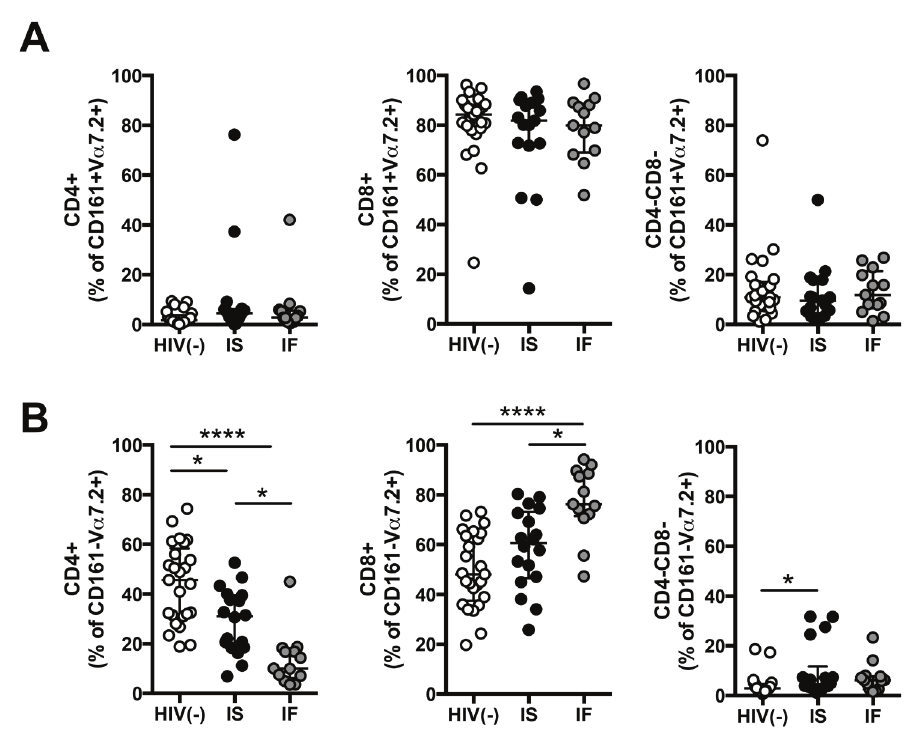
Figure 2. Accumulation of CD8 + Vα7.2 + CD161- Cells in Immune Failure Patients. (A, left) The percent- age of CD3 + Vα7.2 + CD161 + cells that are CD4 + . (A, center) The percentage of CD3 + Vα7.2 + CD161 + cells that are CD8 + . (A, right) The percentage of CD3 + Vα7.2 + CD161 + cells that are CD4-CD8-. All comparisons were P > 0.05 using Kruskal-Wallis test. (B, left) The percentage of CD3 + Vα7.2 + CD161- cells that are CD4 + (Kruskal-Wallis test). (B, center) The percentage of CD3 + Vα7.2 + CD161 + cells that are CD8 + (Kruskal-Wal- lis test). (B, right) The percentage of CD3 + Vα7.2 + CD161 + cells that are CD4-CD8- (Kruskal-Wallis test). * P ≤ 0.05; **** P ≤ 0.000. IS, Immune Success; IF, Immune